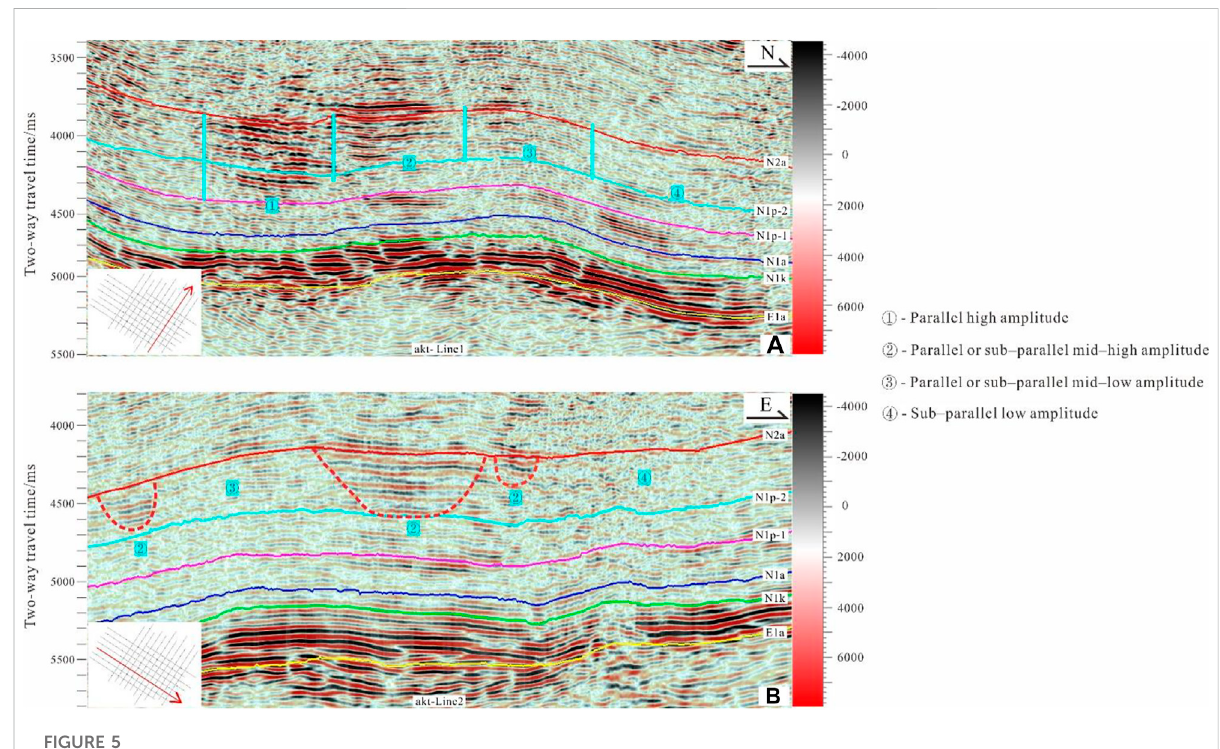
FIGURE 5 Seismic pro fi le of the akt-line1 and akt-line2 in the Akatao survey